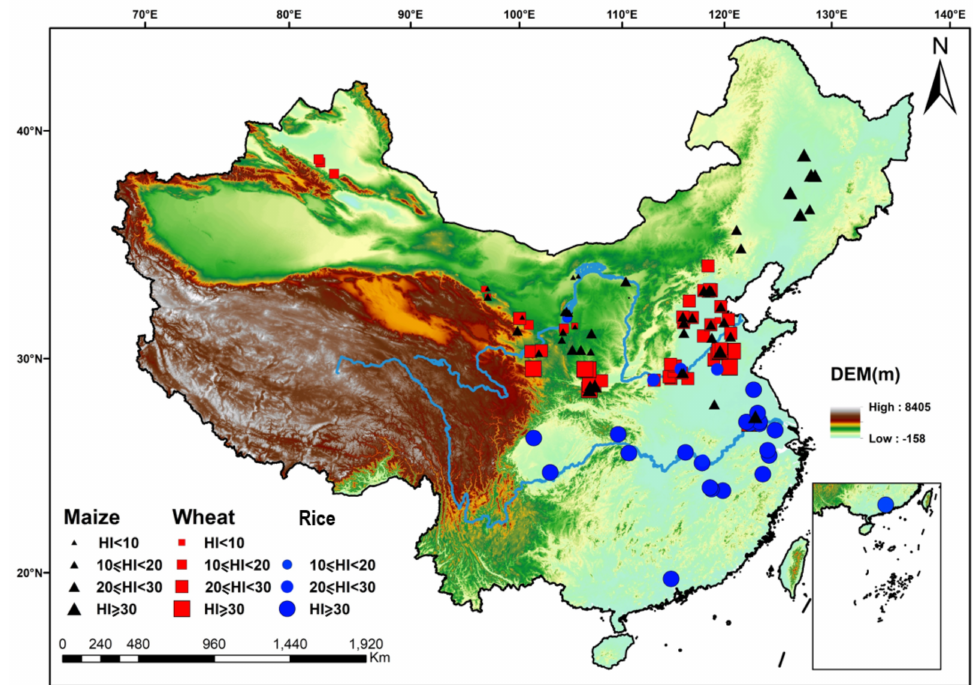
Figure 1. Fertilization or irrigation distribution of field experiment locations for maize, wheat, and rice in this meta-analysis in 1990–2020 ( n = 151). Note: HI, humidity index = MAP/(MAT + 10). The digital Elevation Model (DEM) is a digital simulation of the terrain by using limited terrain elevation data. The symbols represent HI and differ in